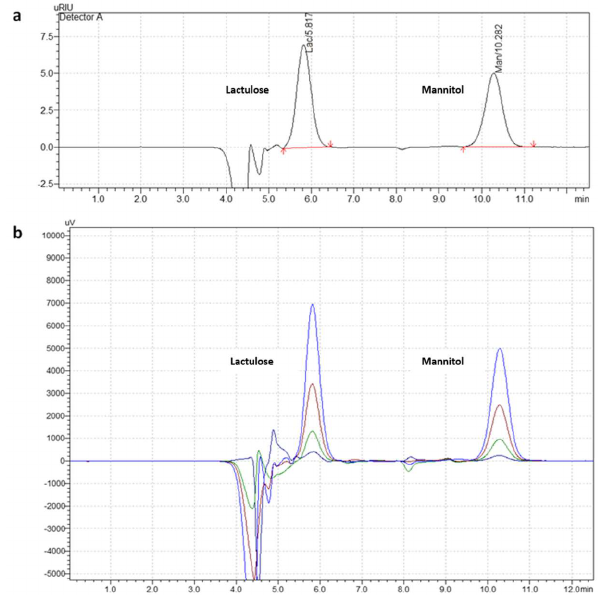
Figure 2. Chromatographic separation of lactulose and mannitol in urine samples spiked with varying concentrations of standard solutions. Chromatograms depict ( a ) the resolution and peak separation of urine spiked with standard solution containing 250 µ g mL − 1 lactulose and mannitol (corrected with the ‘blank’ un-spiked urine sample) at 5.8 and 10.2 min, respectively. ( b ) Each of the sugars eluted at the same retention time following injection of a range of different concentrations of standard solutions that contained 500 µ g mL − 1 (blue), 250 µ g mL − 1 (brown), 125 µ g mL − 1 (green), and 62.5 µ g mL − 1 (black) lactulose and mannitol after correction with the ‘blank’ un-spiked urine